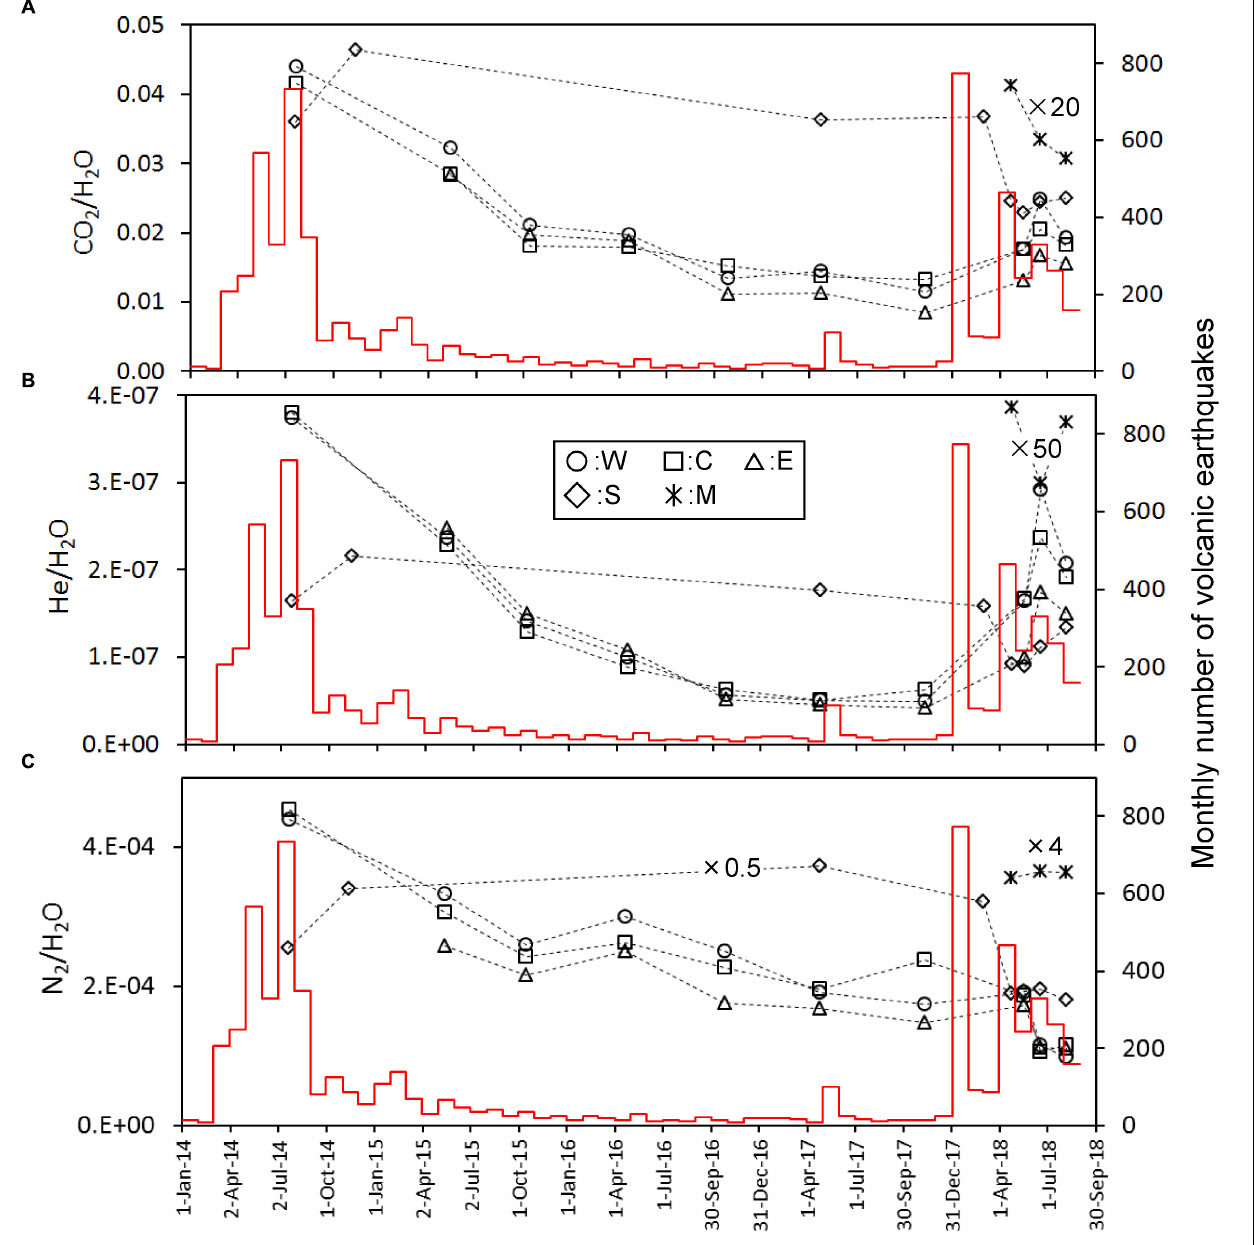
FIGURE 2 | Time variation of CO 2 /H 2 O (A) , He/H 2 O (B) , and N 2 /H 2 O (C) molar ratios calibrated on the left y -axis. Some data were adjusted to the y -axis range by multiplying values indicated in figure. The red histogram calibrated on the right y -axis shows the monthly number of volcanic earthquakes observed by JMA.